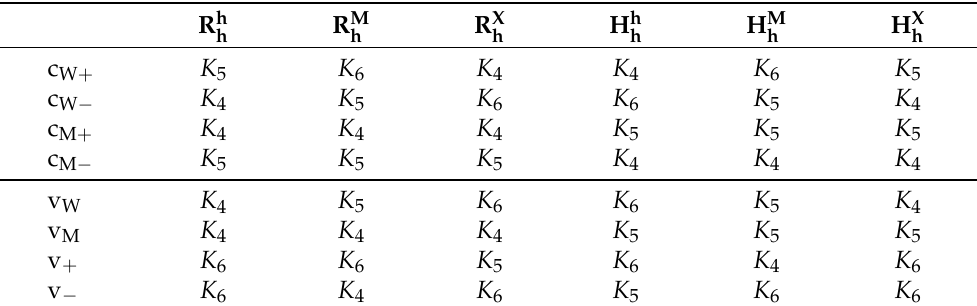
Table 2. Irreducible representations at the K point ( C 3 point group) for the relevant energy bands indicated in Figure 1g for all considered